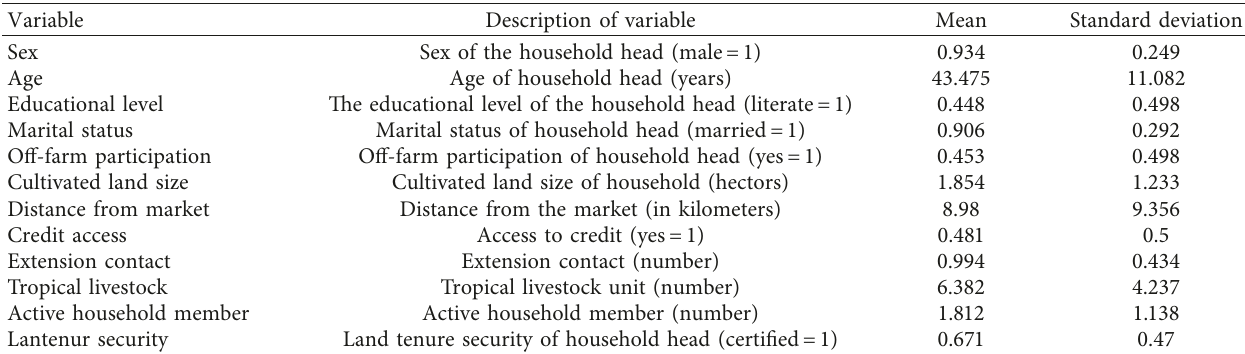
Table 3: Description and summary statistics of the variables used in the analysis.